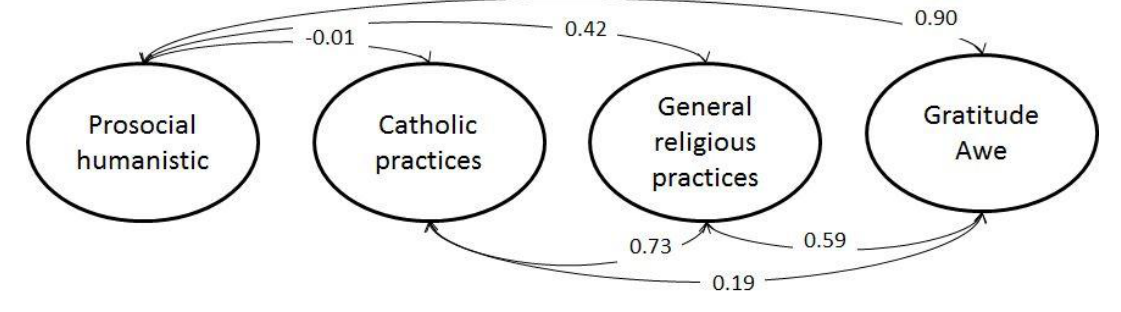
Figure 5. Correlations between factors.